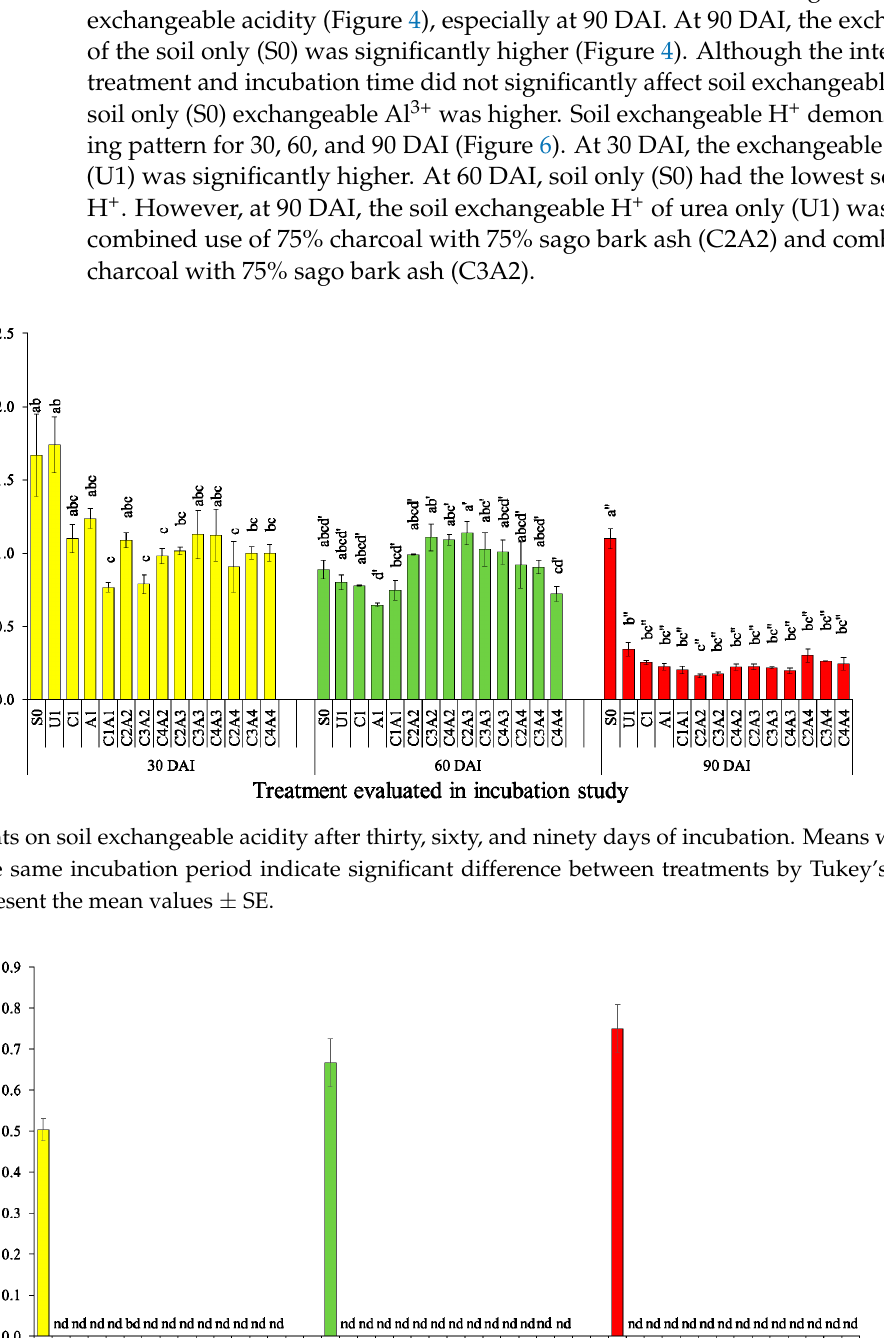
Figure 3. Treatments on soil pH in potassium chloride after thirty, sixty, and ninety days of incuba- tion. Means with different letter(s) within the same incubation period indicate significant difference between treatments by Tukey ’ s HSD test at p ≤ 0.05. Bars represent the mean values ± SE.